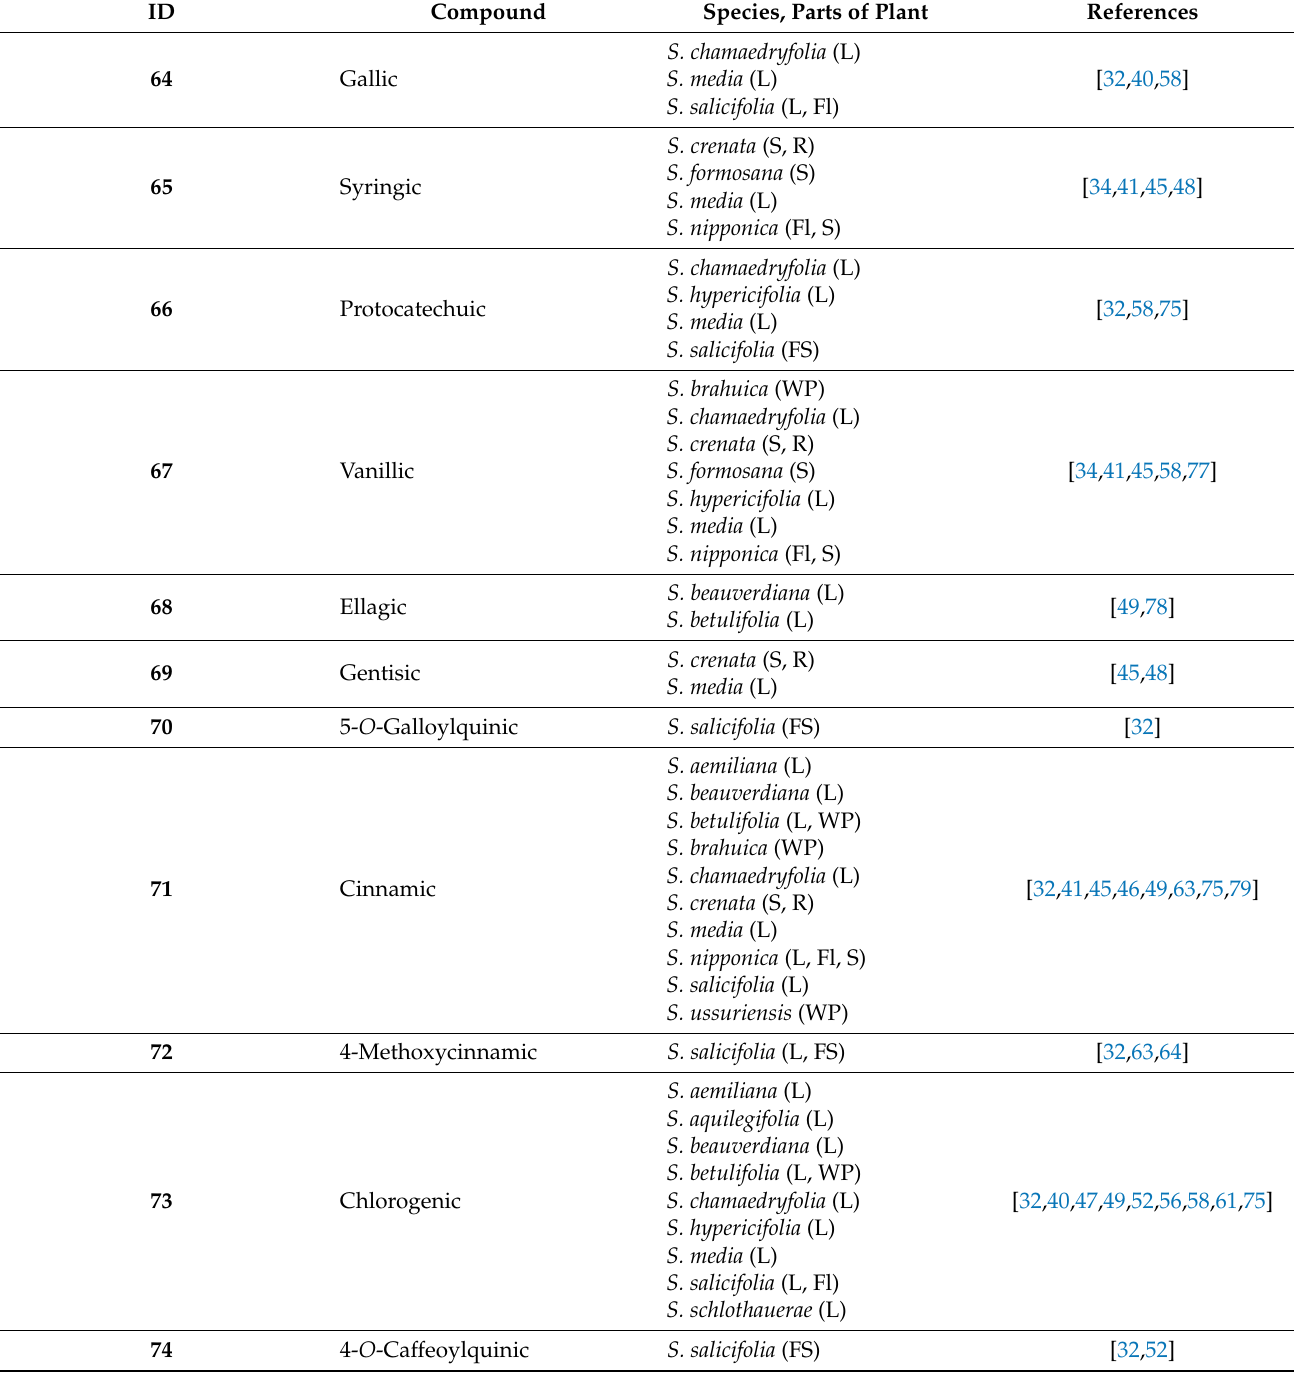
Table 2. Phenolic acids of